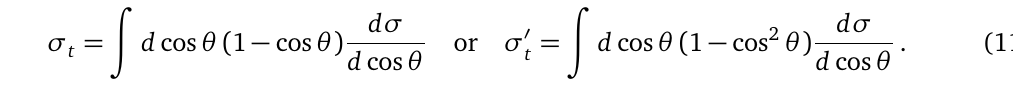
= 0.02. Allowed regions are unshaded, and α int